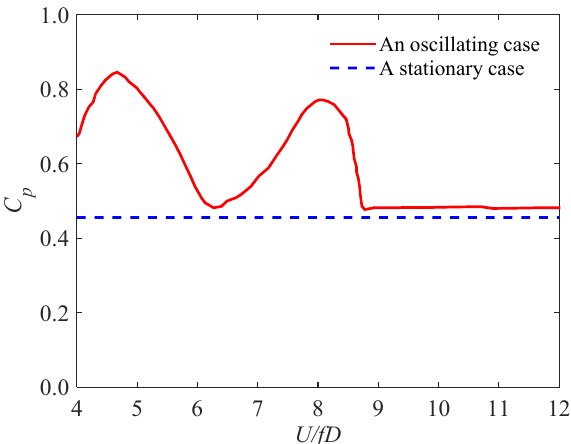
Figure 9. Fluctuating pressure measured on a side face, after [29]. Sensors 2020 , 20 , x FOR PEER REVIEW